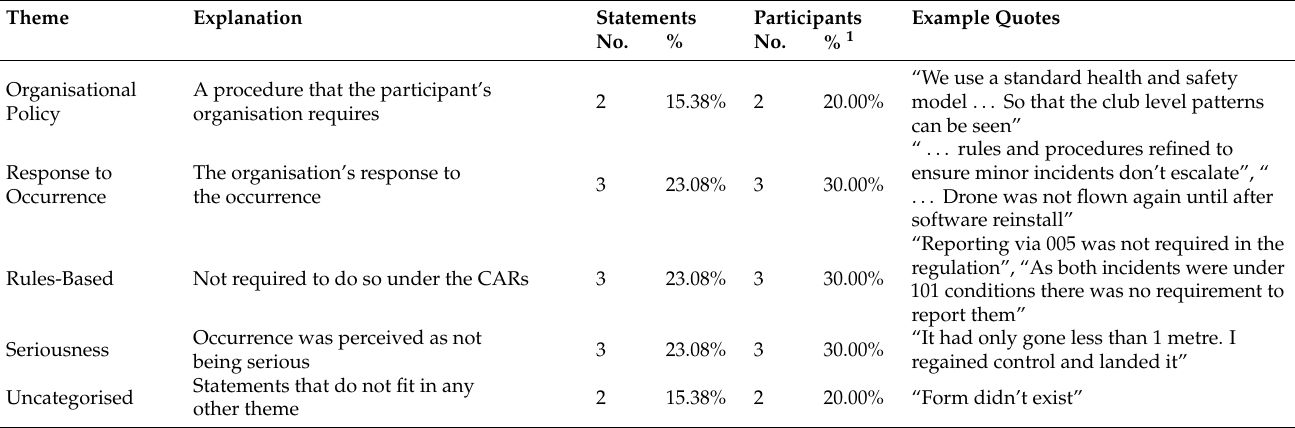
Table 7. Reasons for reporting only internally and not using a CA005RPAS